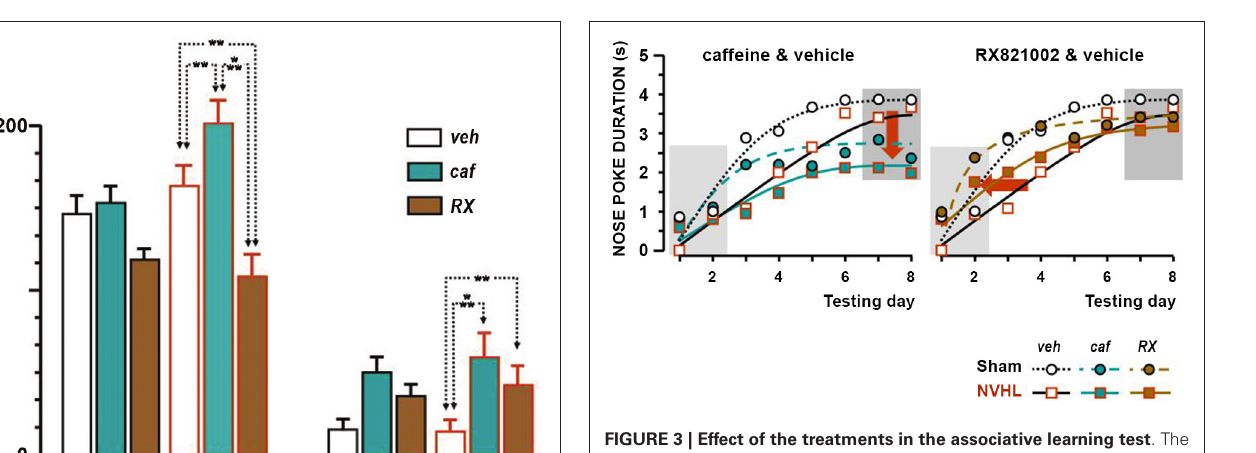
volumes on each side of the brain ( F ( 1,24 ) = 1.12) or in treatment groups ( F ( 2,24 ) = 0.15).